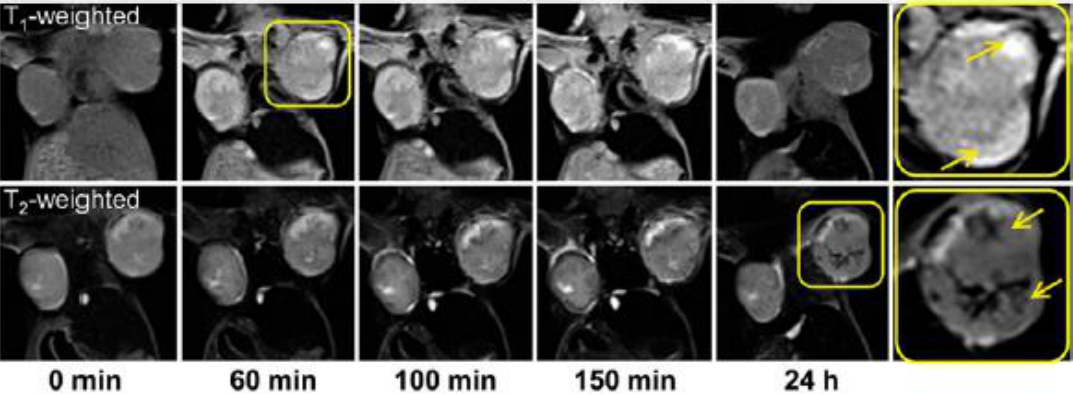
Figure 17. T1- and T2-weighted MRI of a mouse bearing orthotopic 4T1 tumors before and after i.v. administration of ultra-small SPIONs at different time points. Bright contrast with increasing signal in T1-weighted MR images was observed in the tumor, particularly peripheral regions (inset), at early time points (i.e., 5–150 min) resulting from the single-dispersed ultra-small SPIONs, whereas signals in several regions of the tumor turning dark (arrow indicated) were observed in T2-weighted images 24 h after ultra-small SPIONs injection because of ultra-small SPIONs clustering in the tumor interstitials. (Image reprinted with permission from [104], ACS, 2017).